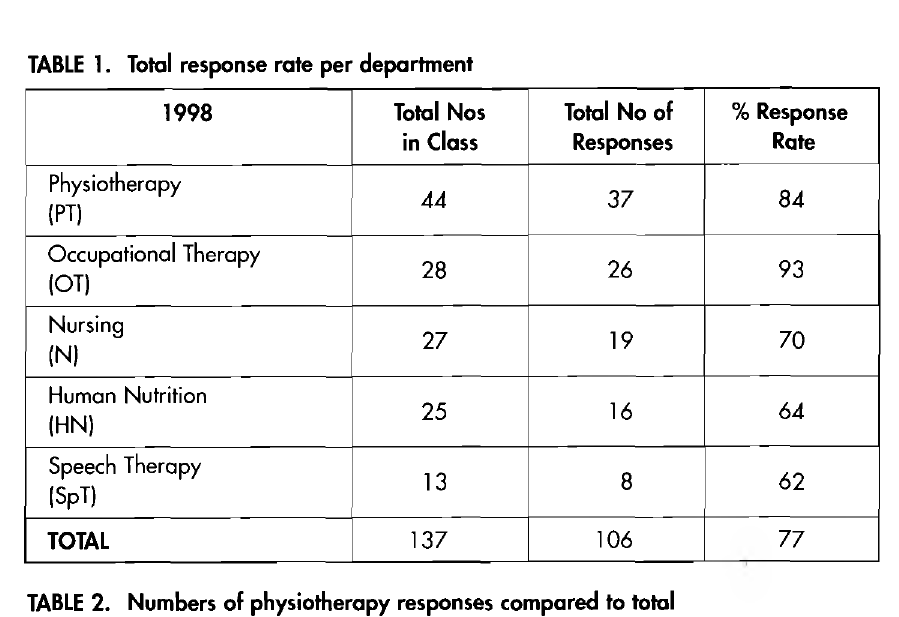
TABLE 1. Total response rate per department